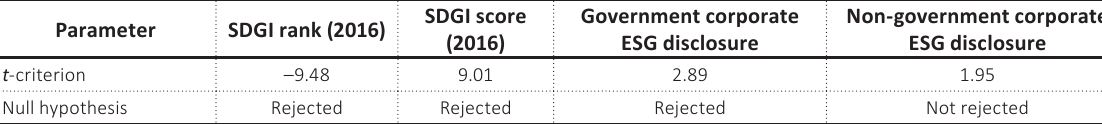
Table C1. T -test of the differences between developed countries and emerging countries Parameter SDGI rank (2016) Rejected